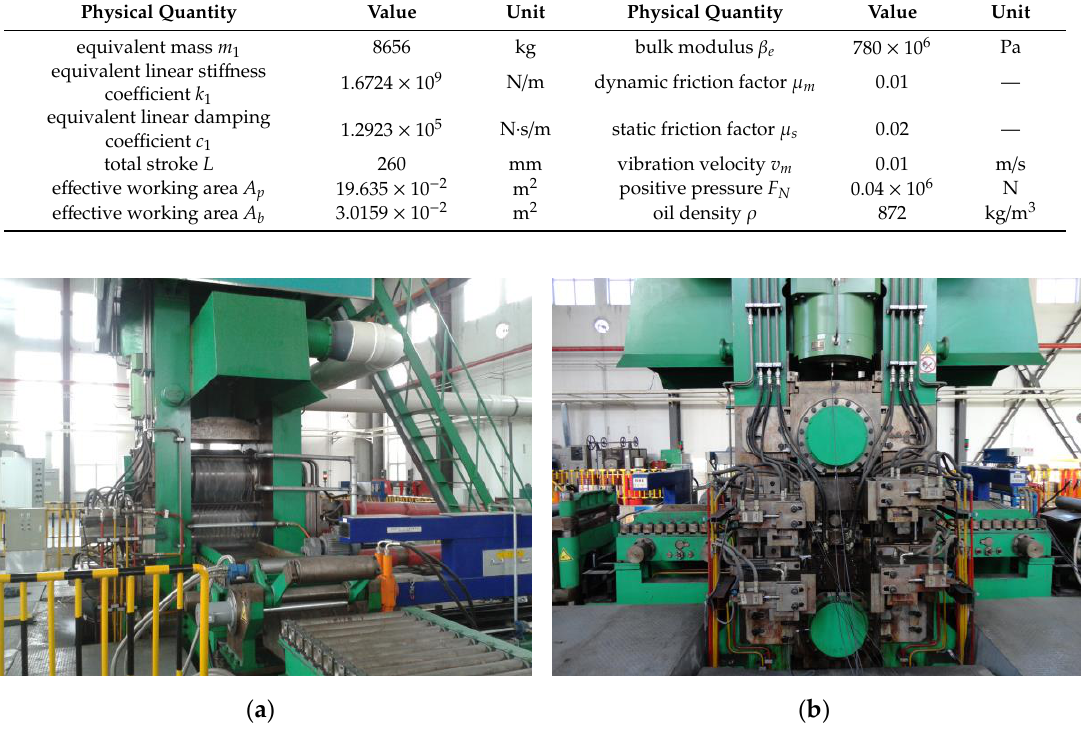
Figure 5. Photos of the 650 4 / 6-roll cold rolling